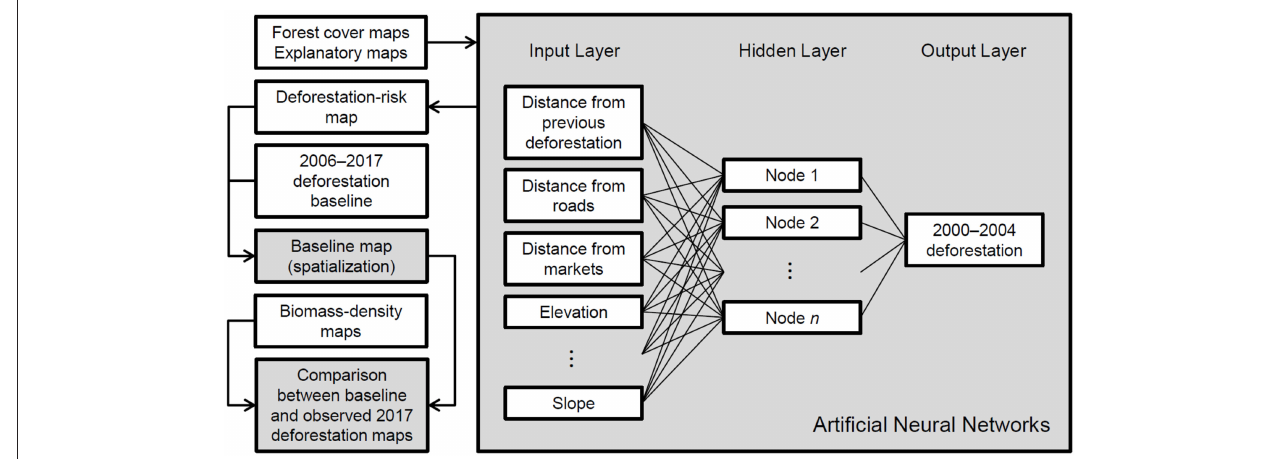
FIGURE 2 | Flowchart of the deforestation baseline spatialization based on artificial neural networks (ANN). Relationships among variables associated with deforestation from the Input Layer (“neurons”) are established in the nodes of the Hidden Layer as an exercise to reproduce the observed pattern of deforestation in the Output Layer . The ANN output is a raster map with ranked likelihoods of deforestation at the pixel level. White boxes represent inputs or outputs, shaded boxes represent processes.